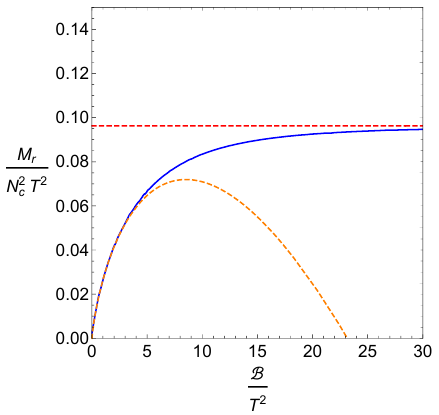
Figure 4 . The dimensionless magnetisation m r = M r /T 2 , divided by N 2 (solid blue line), compared with the analytical solutions at small b (orange dashed line) and large b (red dashed line). The analytical solutions at small b and large b are derived in appendices A and B.